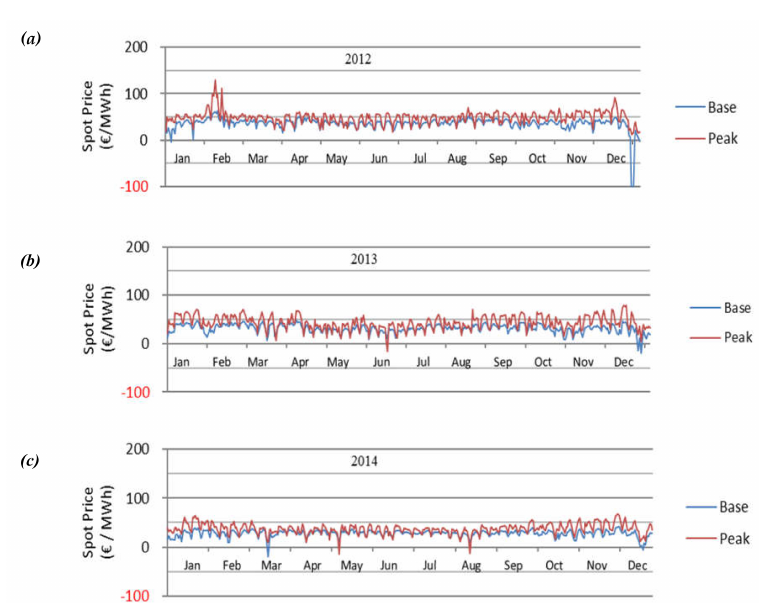
Figure A1. ( a – c ) EEX spot market prices, base-load and peak-load, 2012–2014. Source: own illustration, based on weekly EEX data (1 January 2012–31 December